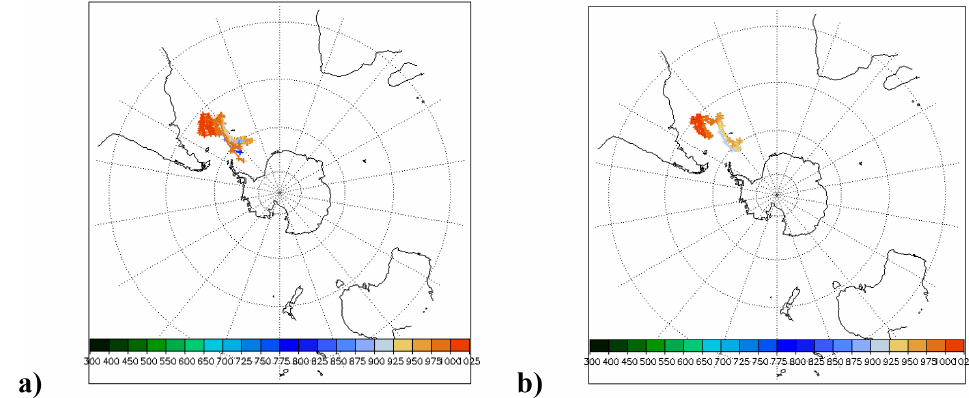
Figure 7. Five-day air mass back trajectories for 30 January 2007 (a) and 31 January 2007 (b) during episode A. The color indicates the pressure level (hPa).